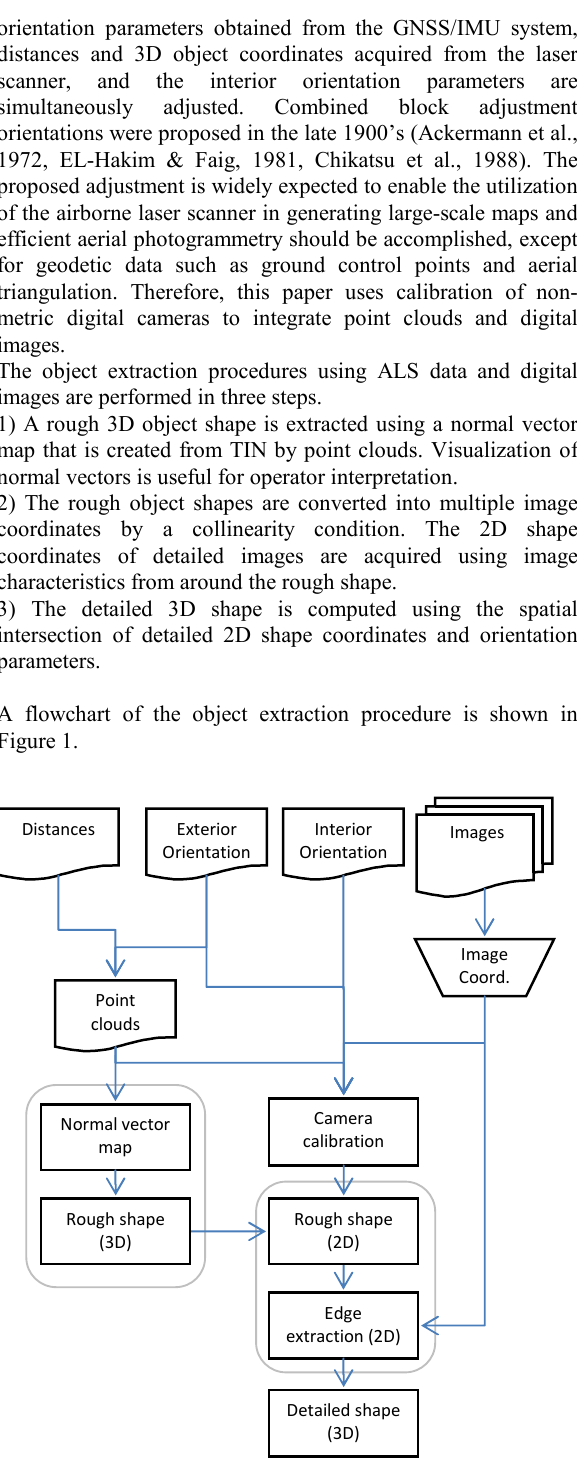
Figure 1. Object extraction flowchart